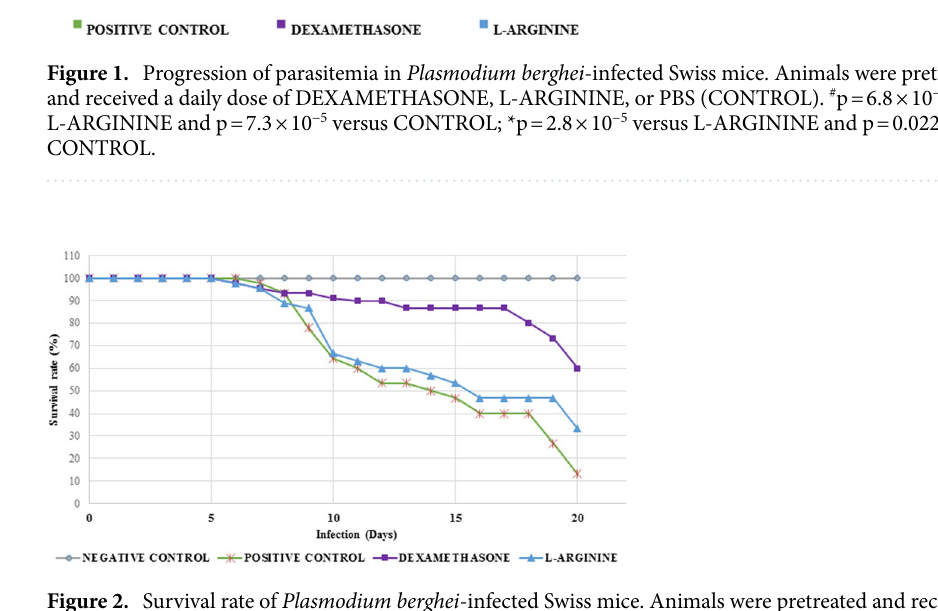
Figure 2. Survival rate of Plasmodium berghei -infected Swiss mice. Animals were pretreated and received a daily dose of DEXAMETHASONE, L-ARGININE, or PBS